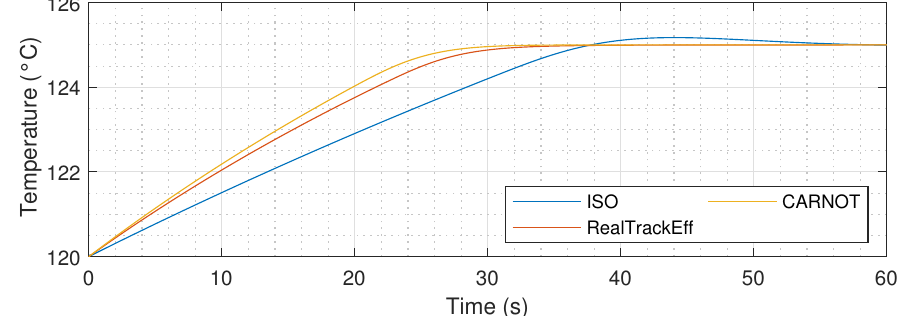
Figure 10. Outlet temperature of the HTF of the LFC on the 8 August 2019 for the PID tuning. The flows are displayed in Figure 11. As can be seen, the flow saturates at the start as the flow rate is limited by the minimum Re of 10,000 for the 3 models, corresponding to a flowrate of 1.6 L · s. Once the value of the desired flow is above the lower limit, it increases beyond saturation (20.5 s for the CARNOT, 21.8 s for RealTrackEff and 30.8 s for ISO). RealTrackEff and CARNOT see their flow stabilising much faster than the ISO9806 model, which also presents an overshooting at 50 s. This shows that CARNOT and RealTrackEff behave similarly, although the controller has been defined for RealTrackEff. The final value of the stabilised flowrate for RealTrackEff (3.9 L · s − 1 ) is lower than CARNOT (4.5 L · s − 1 ). The flowrate for the ISO, on the other hand, peaks at 7.1 L · s − 1 , denoting a huge difference